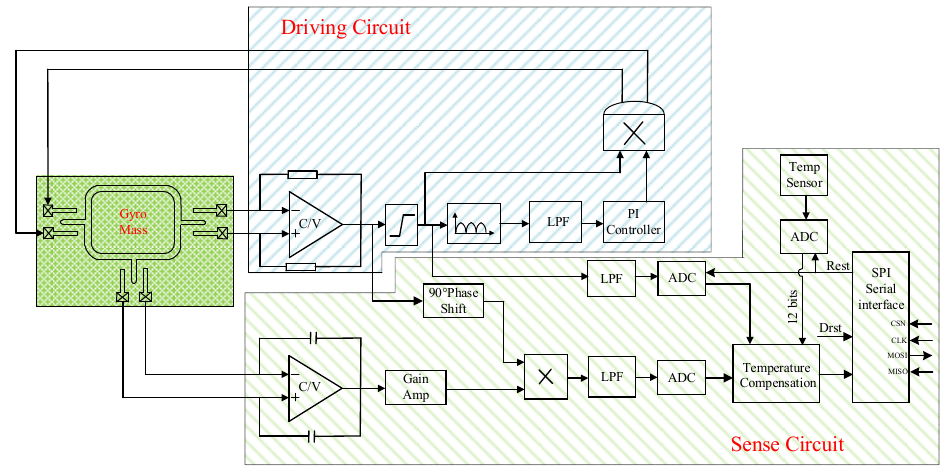
Figure 10. Topology structure of MEMS gyroscope interface circuit.